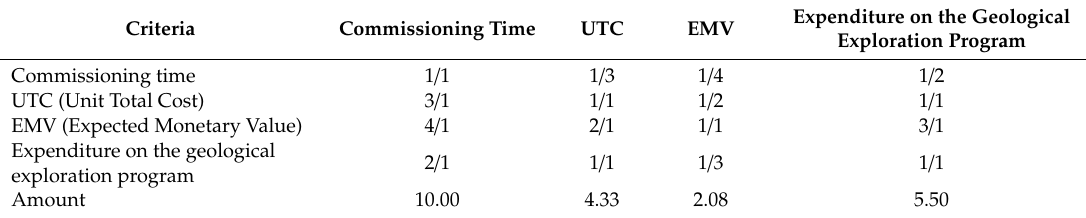
Table A2. Results of assessment of relative importance of investment sustainability criteria.